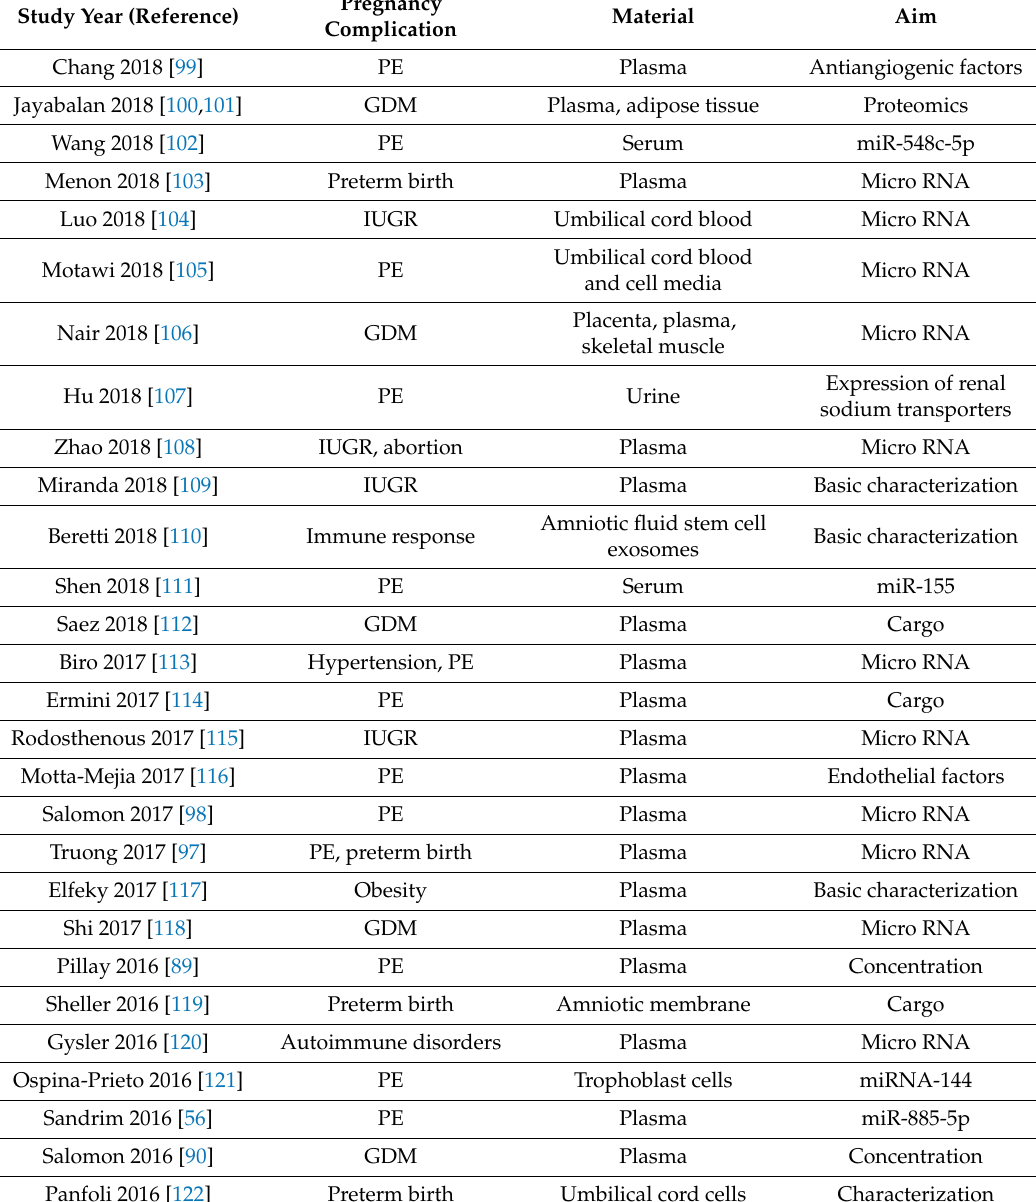
Table 1. Chronological overview of studies regarding exosomes and pregnancy complications from years